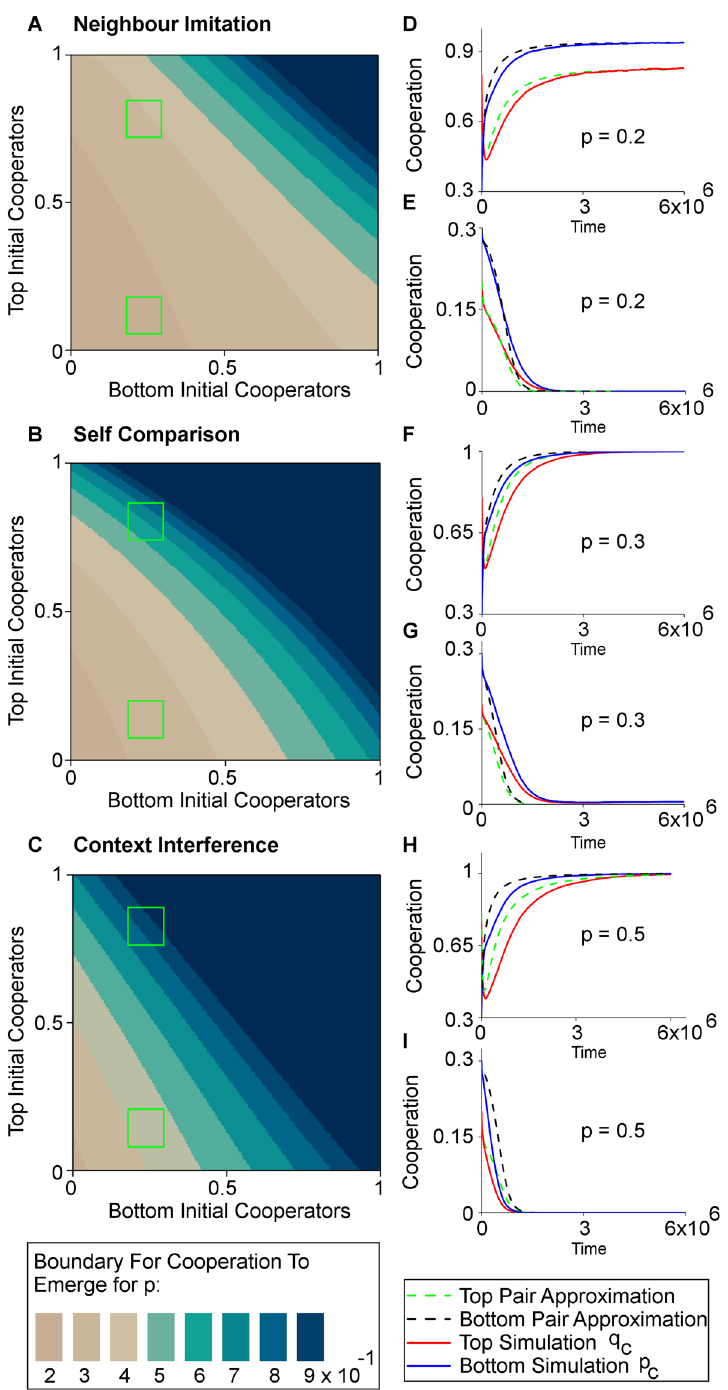
Figure 4. Bistability phenomenon. Spillover can hinder or promote cooperation depending on initial conditions. ( A – C ) illustrates, for each frequency of spillover p , the initial level of cooperators that would result in zero cooperation at equilibrium, under each spillover mode. In all cases, for a fixed p , there is a threshold level of initial cooperators on each network layer beyond which the spillover effect switches to working in favor of cooperation. The initial proportion of cooperators required for spillover effect to give rise to cooperation becomes more demanding as p increases. Context interference is shown to be most resilient to this, followed by self comparison, while neighbour imitation is the most vulnerable. ( D – I ) demonstrates the bistability phenomenon for selected parameter combinations ( )  with both simulation and pair